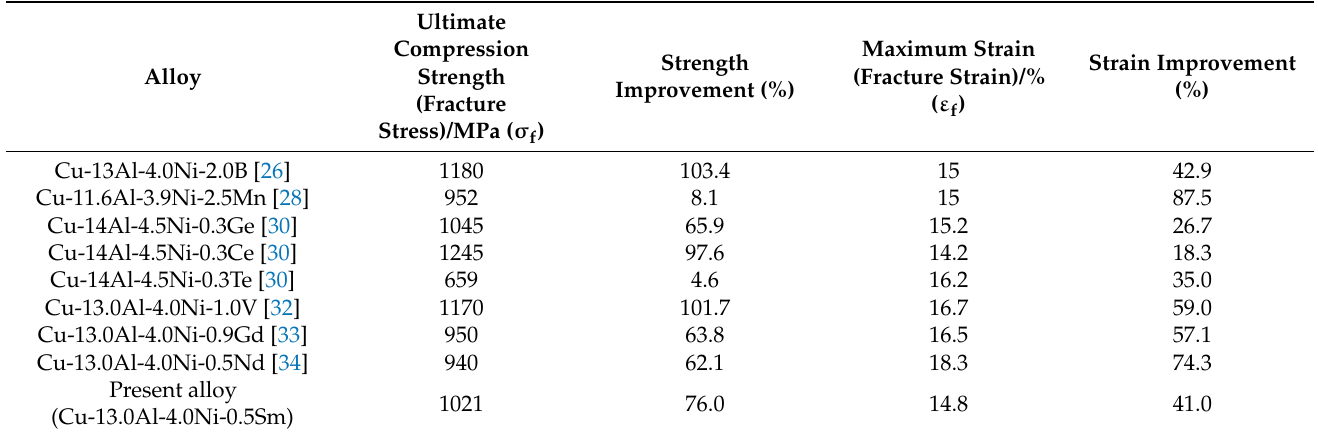
Figure 5. Compressive stress–strain curve of Cu-13.0Al-4.0Ni- x Sm ( x = 0.2, 0.5) alloys. Table 2. Comparison with the mechanical property data and improvement degree of other Cu-Al-Ni alloys doped with a fourth element.